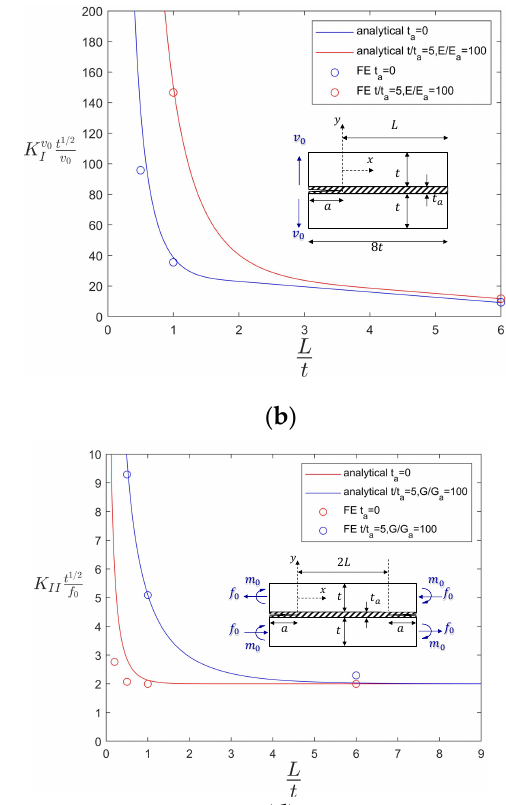
( b ) Figure 6. The crack problem definition for Case 3. ( a ) Geometry and load conditions. ( b ) Elastic foundation idealization. 2.3. Analytical Results and Implications To gain insights into the closed-form solutions developed in Section 2.2 above, the non-dimensional plots of the stress intensity factors with selected geometry and loading